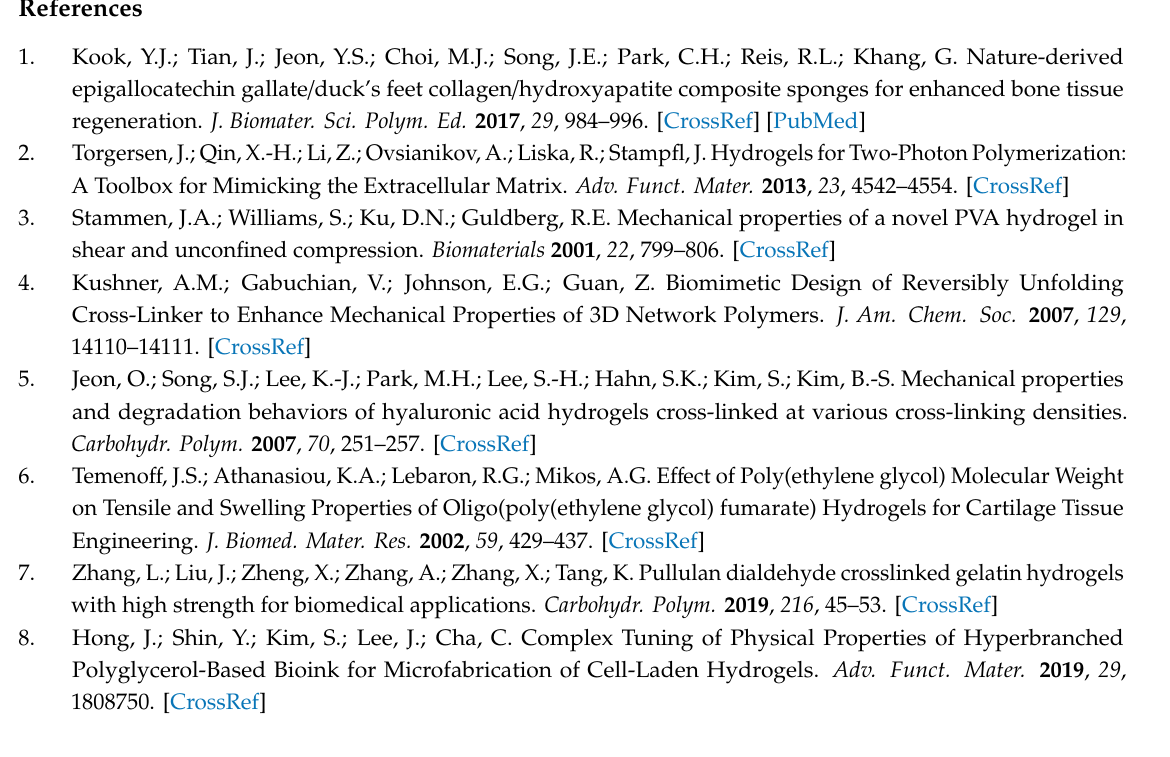
Figure S1: Synthetic scheme of CME-PRXs, Figure S2: SEC charts of α -CD, PEG, PRX-24%, and PRX-37%, Figure S3: Mechanical properties of gelatin hydrogels cross-linked by di ff erent amounts of CME-PRX-37% and EDC / NHS, Table S1: Characterization of gelatin hydrogels with di ff erent concentration of CME-PRX-37% crosslinkers and amounts of EDC /